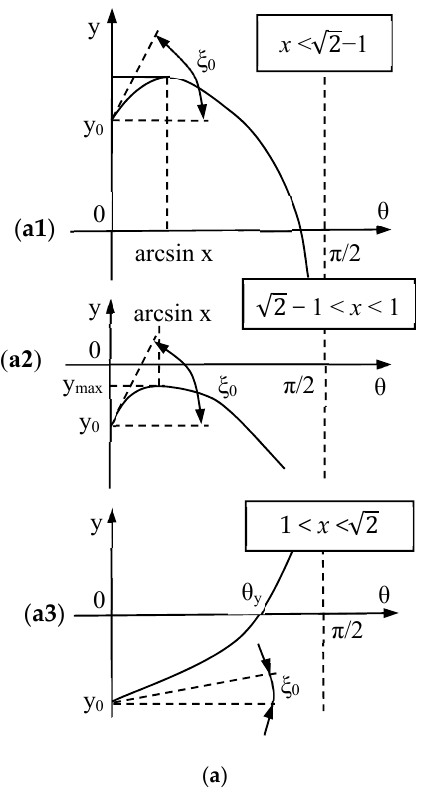
Figure 4. ( a1 – a3 ) Transversal and ( b ) longitudinal/axial migration functions studied for: ( 1 ) x < √2